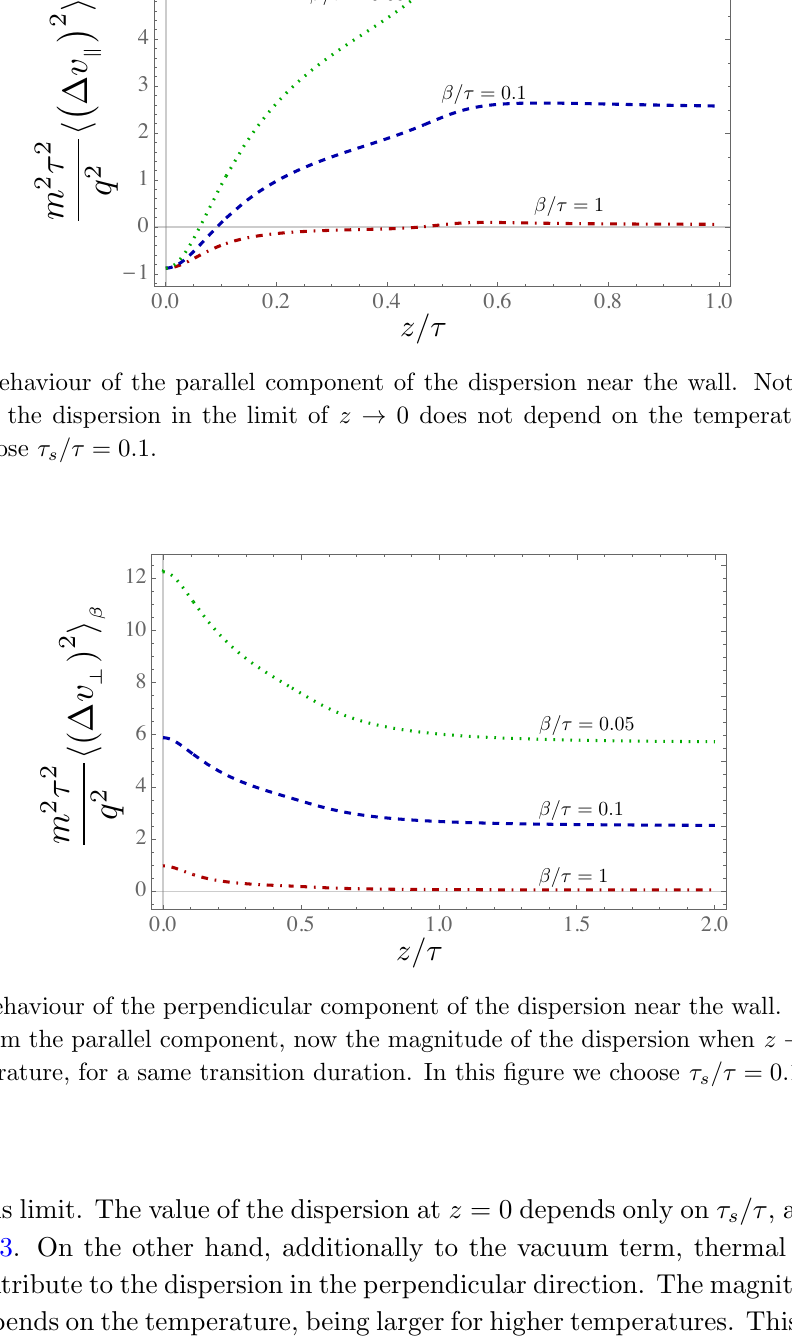
to zero in this limit. The value of the dispersion at z = 0 depends only on (cid:28) s =(cid:28) , as